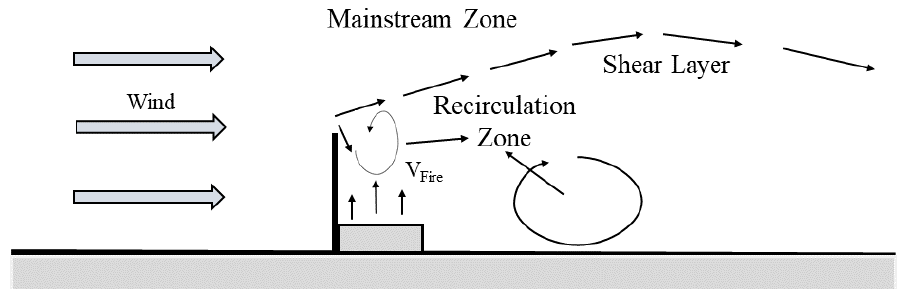
Figure 5. Structure of the flow field.